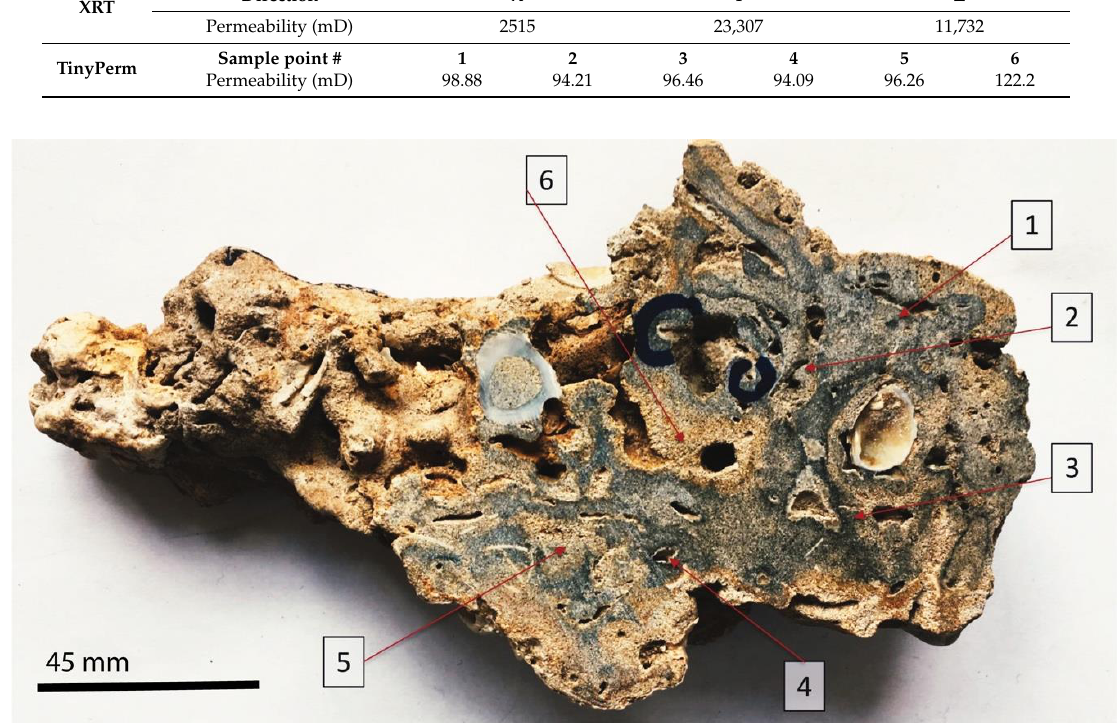
Figure 9. Permeability measured (through air injected decay pressure) from the matrix of sample. Individual permeability values given in Table 2. Average permeability 100.35 mD. Table 2. Permeability values recorded using X-ray tomography (XRT) in the X, Y and Z directions, and TinyPerm from points 1–6 in Figure 9.